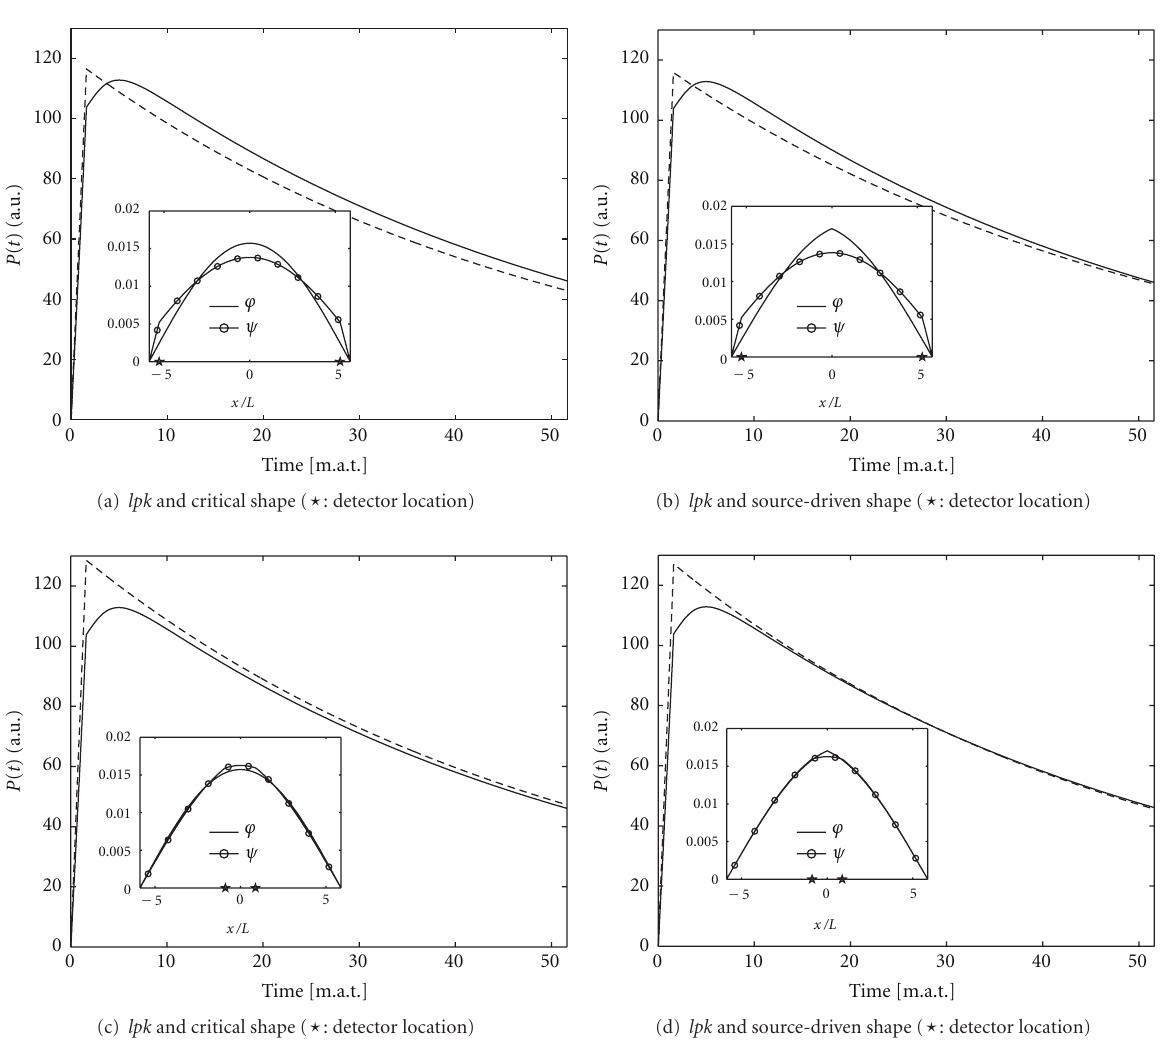
Figure 4: Power evolution following a source pulse in a subcritical system ( k e ff = 0 . 98), simulated with a lpk approach, considering two di ff erent detector locations: first row, detector far from the source ( x 0 = 5 . 3L); second row: detector close to the source ( x 0 = 0 . 9L). Solid line: reference; dashed line: point kinetics. The inset graphs represent the shape ϕ and the weight ψ